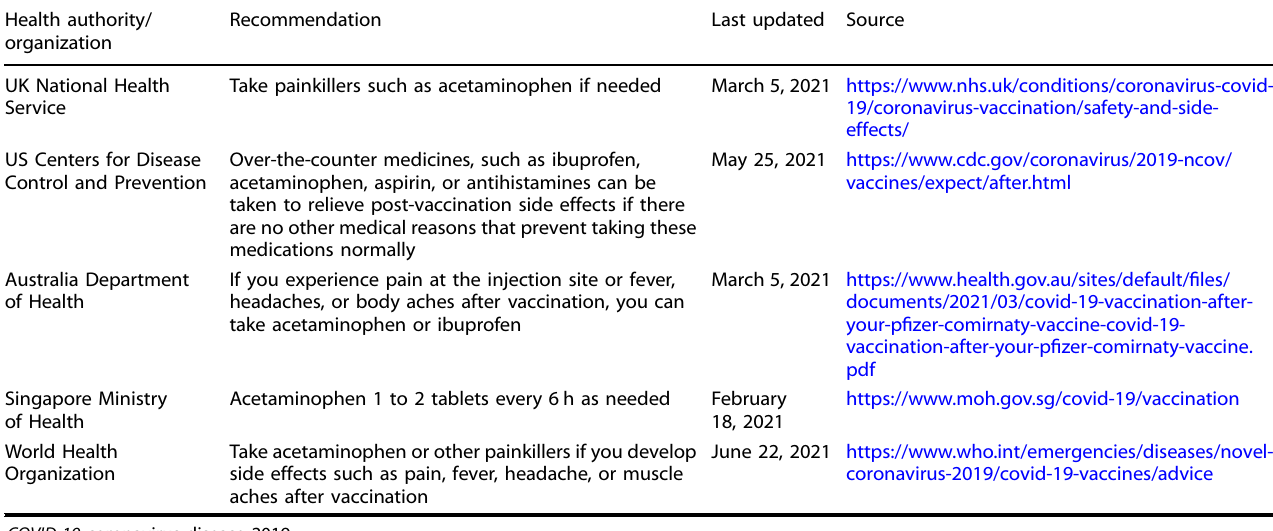
Table 4. Recommendations on analgesic/antipyretic medication for the relief of symptoms following COVID-19 vaccination from various health authorities and